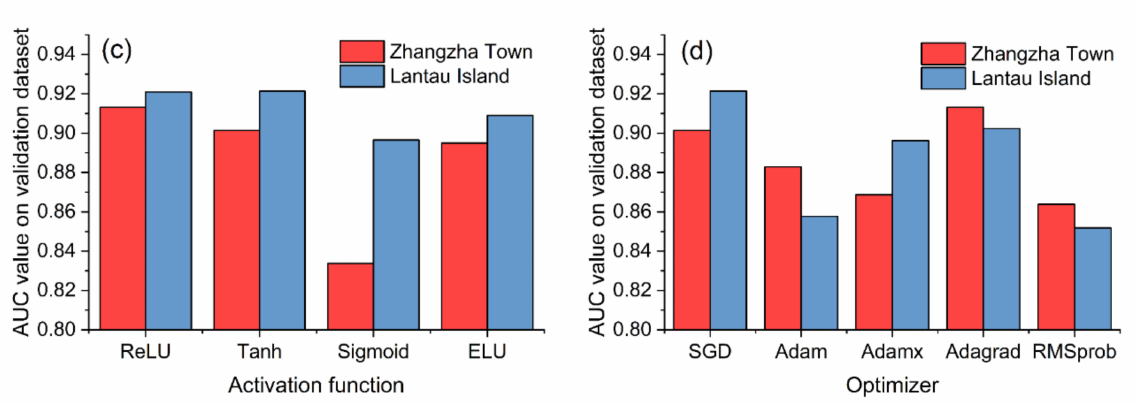
Figure 13. Area under the curve (AUC) values of CNN-based model on testing dataset under different hyperparameters: ( a ) the neurons in the hidden layer, ( b ) the batch size, ( c ) the activation function, and ( d ) the